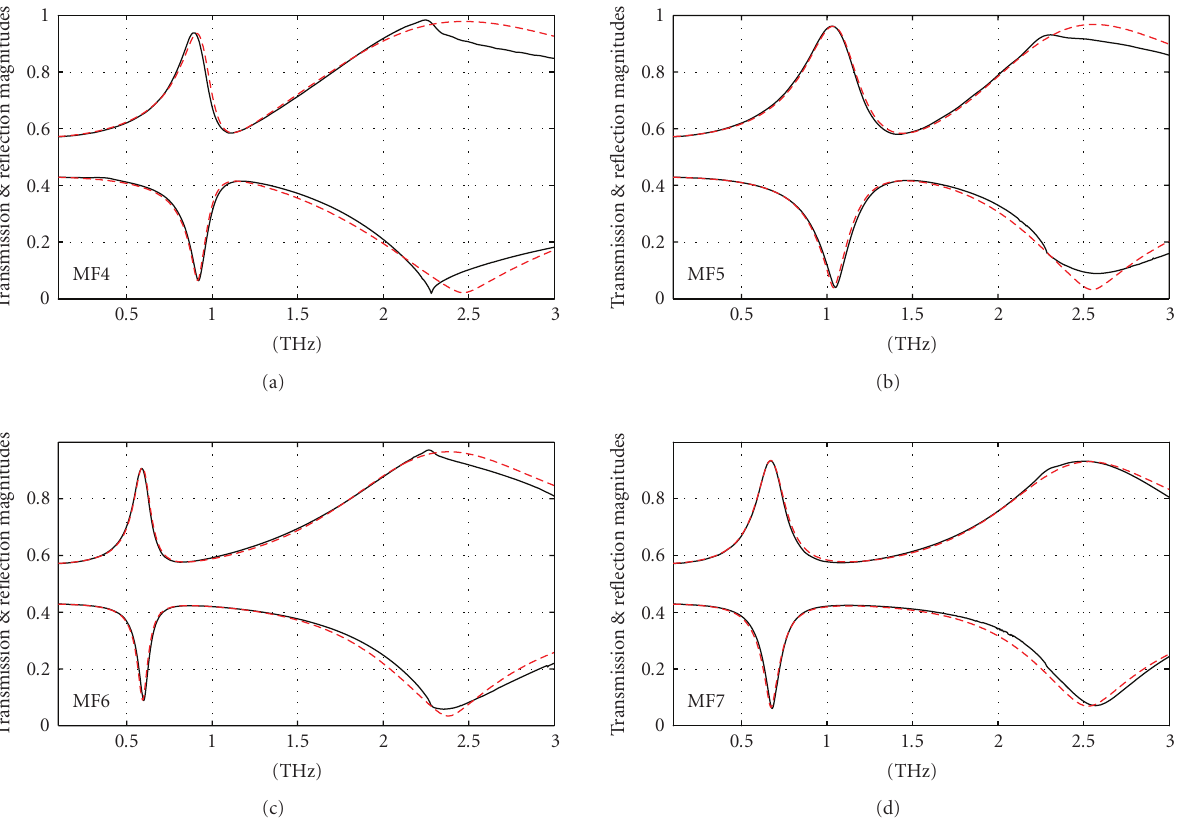
Figure 5: Transmission and reflection coe ffi cients based on simulation and the TL-RLC circuit model for metafilm samples MF4, MF5, MF6, and MF7. Simulation results are shown in black. Red-dashed curves show the combined reflection and transmission coe ffi cients based on the TL-RLC